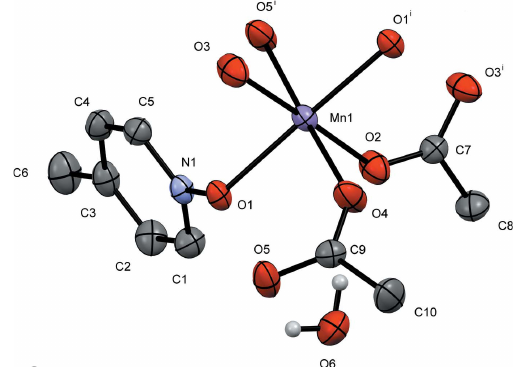
Figure 3 A view of compound III , showing the atom labeling. Displacement ellipsoids are drawn at the 50% probability level, H atoms not involved in hydrogen bonding have been omitted for clarity. [Symmetry code: (i) (cid:4) x + 1 , y (cid:4) 1 , (cid:4) z + 3 .] 2 2 2